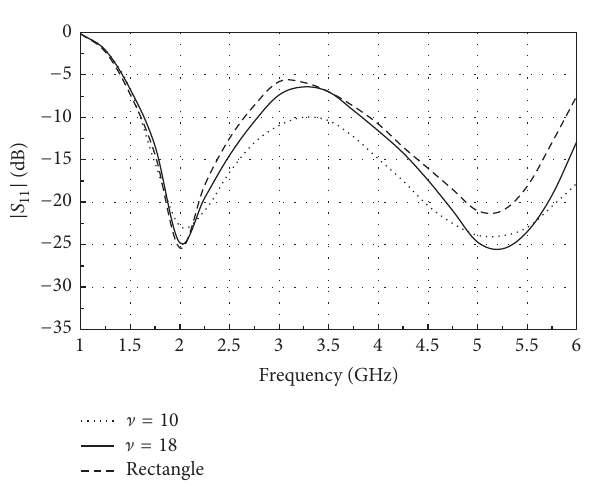
Figure 8: Characteristics of |𝑆 11 | by varying ] .